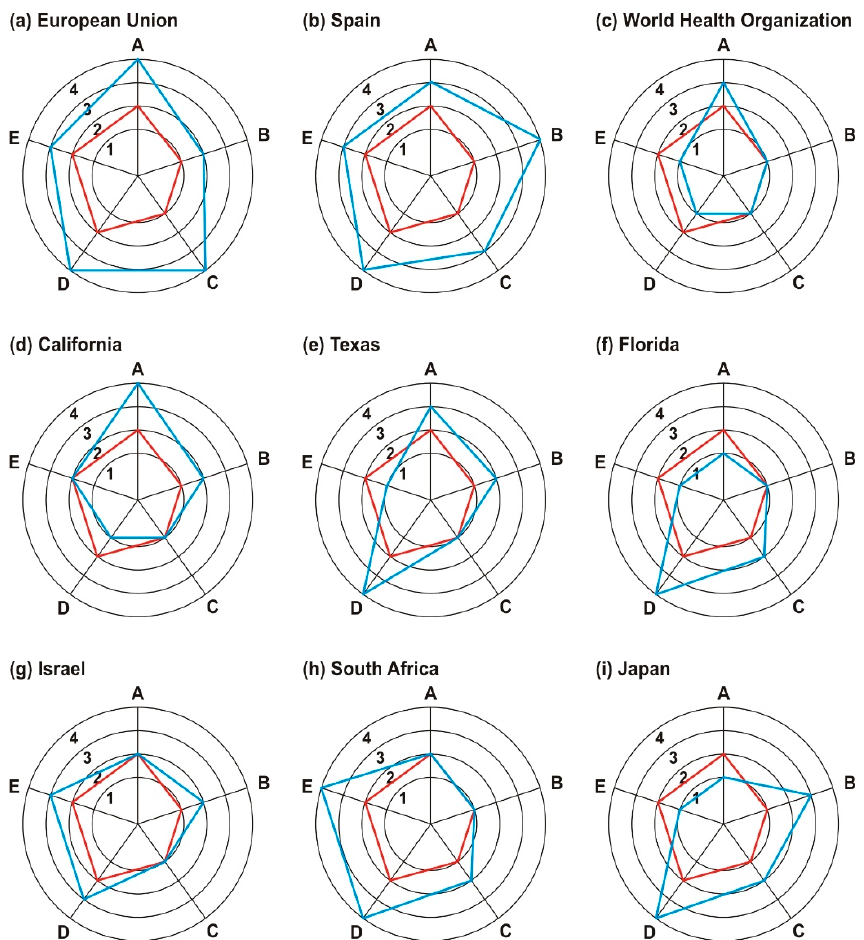
Figure 3. Comparison of the Moroccan ( a ) (red polygons) and other eight ( b through i ) international regulations (blue polygons) for treated wastewater reuse for irrigation agriculture. The comparison used five basic quality standards as evaluation criteria (A—total coliforms, water quality A; B—total coliforms, water quality B; C—total coliforms, water quality C; D—BOD 5 ; and E—SS) and an ordinal score ranking from 1 to 4 (1—regulation includes the criterion, 2—regulation includes the criterion with a relatively permissive threshold or without legal force, 3—regulation includes the criterion as average threshold, and 4—regulation includes the criterion with a very restrictive level).